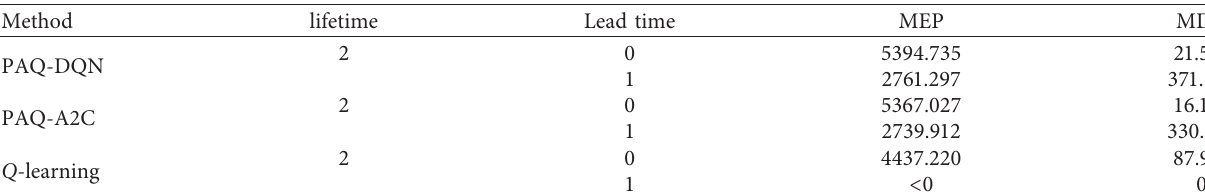
Table 12: Results.